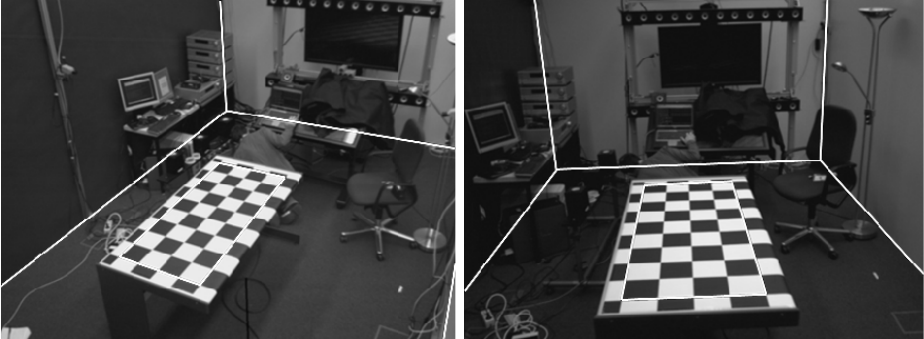
Figure 17. Drawing from two cameras of the outline of the